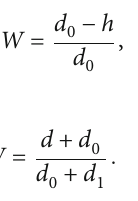
Figure 6: Process system diagram of ultra-high-pressure hydraulic slitting